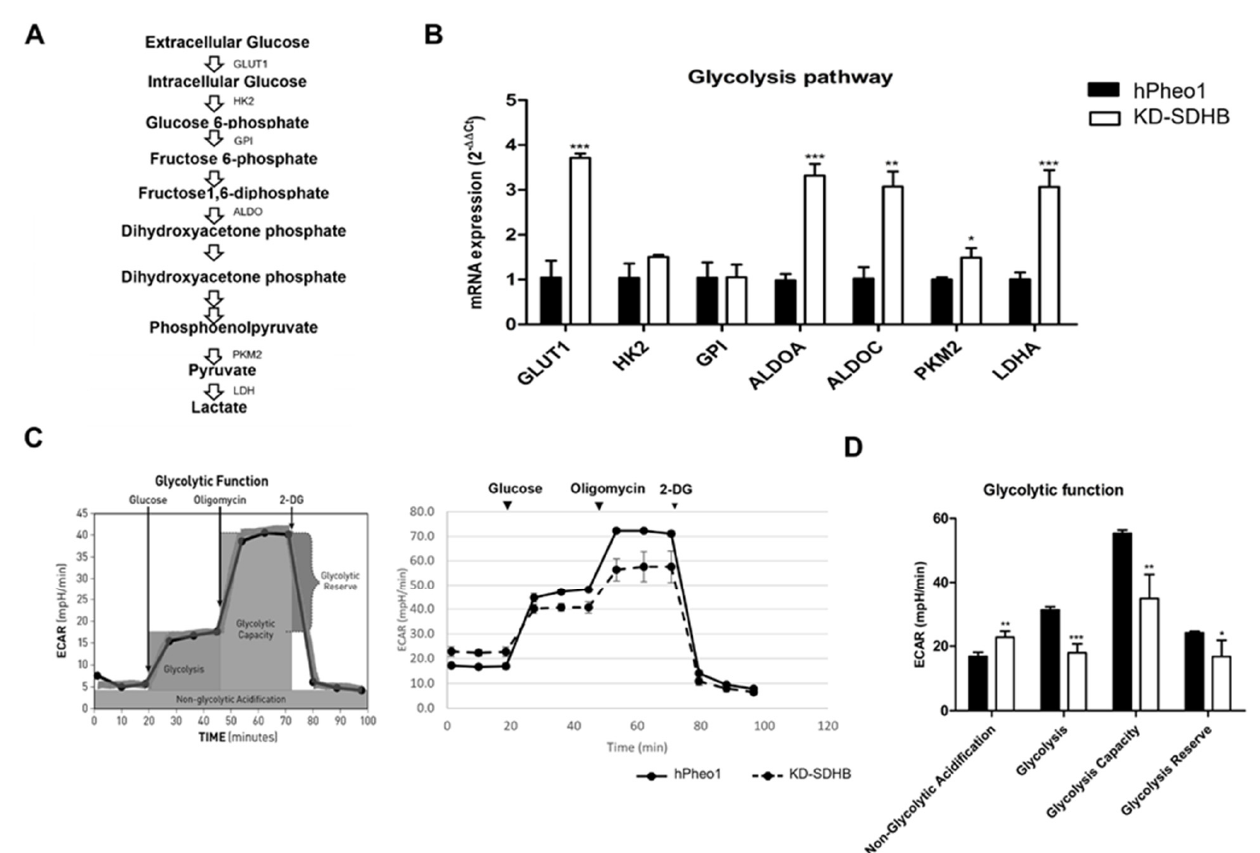
Figure 5. ( A ) Summary indicating the glycolysis pathway. ( B ) Upregulation of the glycolysis gene set by knocking down SDHB. Each bar represents the mean ± standard deviation, * ( p <0.01), ** ( p < 0.001), *** ( p < 0.0001), student’s t -test. ( C ) The Agilent Seahorse XF24 analysis of glycolytic function shows an alteration in the ECAR in KD-SDHB cells compared to hPheo1 cells. Seahorse XF24 analysis performed using Glycolysis-stress test kit (normalized to cell number). Glycolysis stressor compound was added in specific point time. ( D ) Specific parameters for non-glycolytic acidification, glycolysis, glycolytic capacity, and glycolytic reserve were calculated according to manufacturer’s protocol. Values are means ± standard deviation of at least three technical replicates at each time point (see experimental procedures for details). Student’s t ‐ test p values indicated as * ( p <0.01), ** ( p < 0.001) and *** ( p < 0.0001).